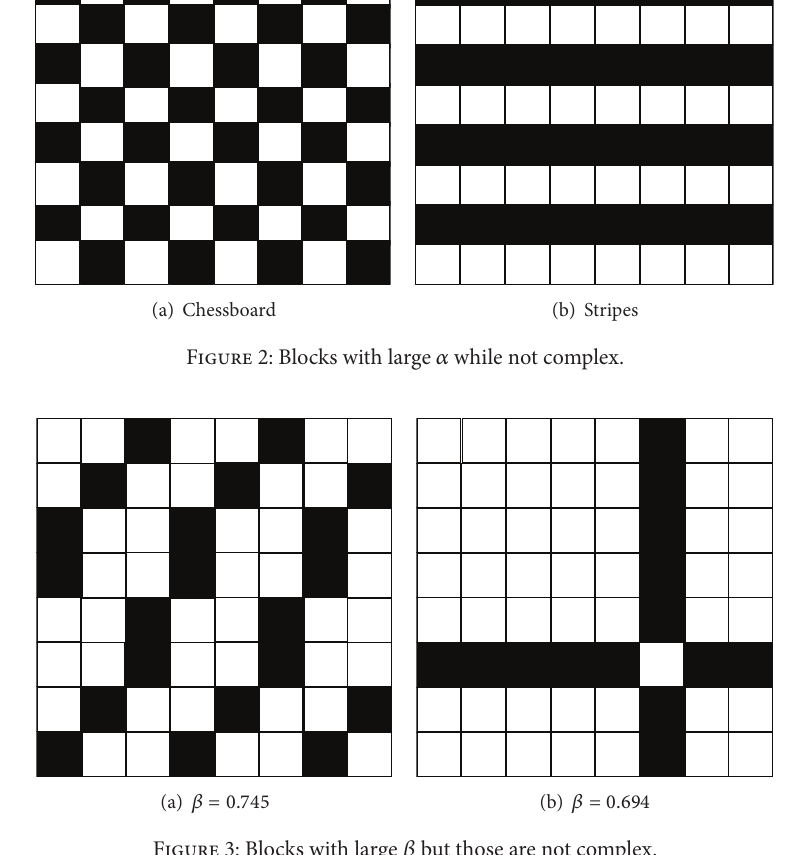
Figure 3: Blocks with large 𝛽 but those are not